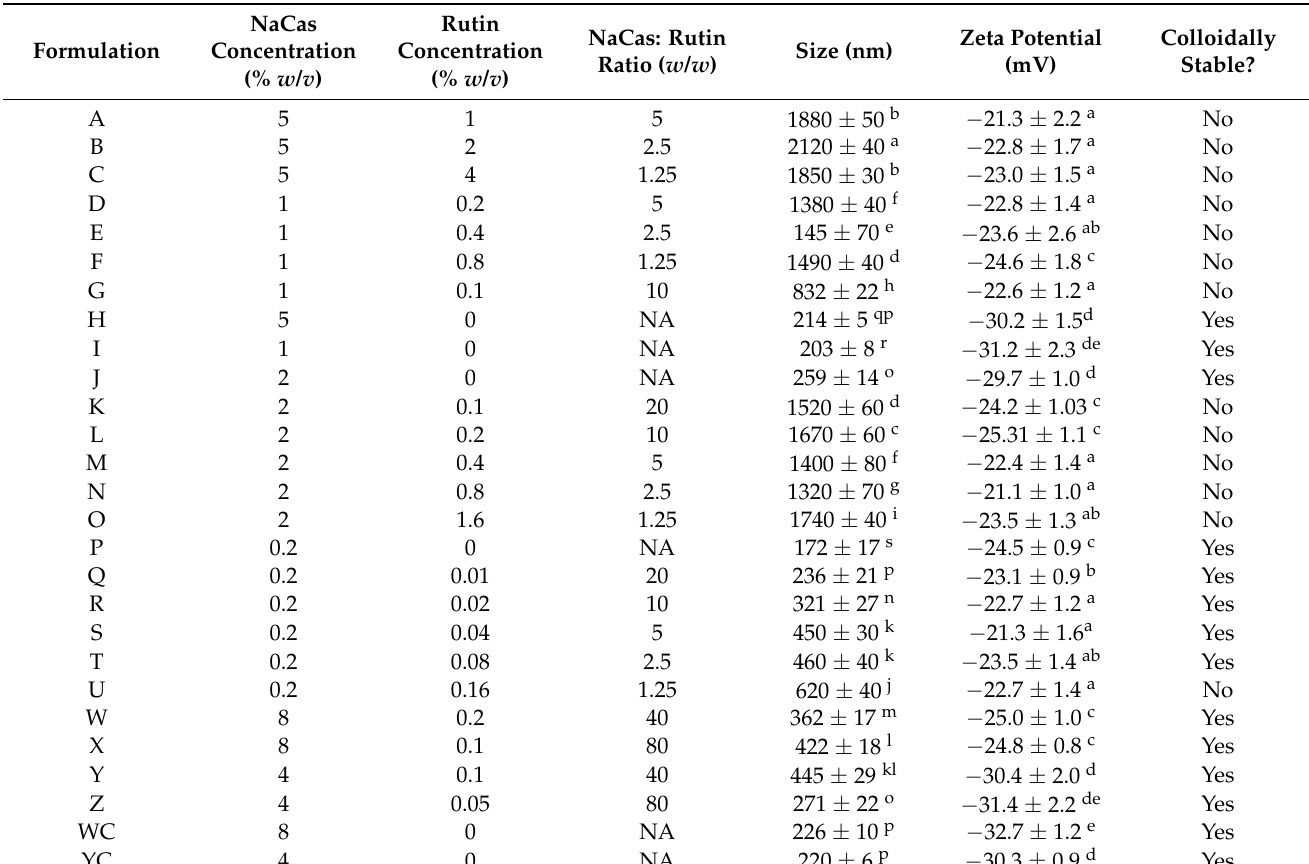
Table 1. The effect of sodium caseinate (NaCas):rutin ratio on the size, surface charge, and stability of the particles in the encapsulation system (pH